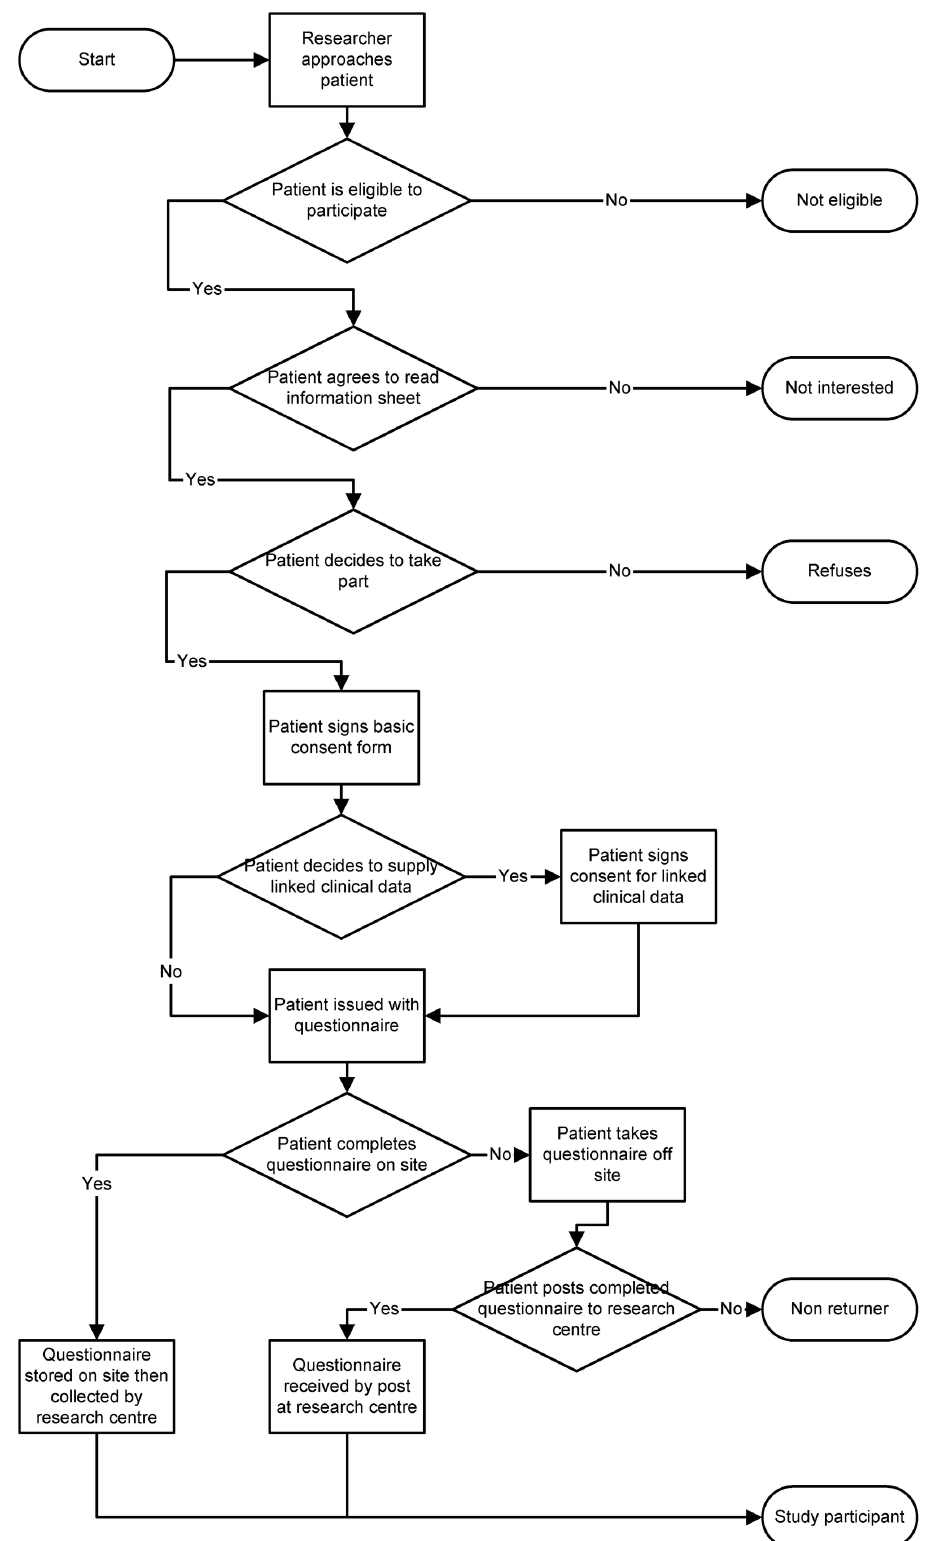
Figure 1. Flowchart of ASTRA clinic recruitment and questionnaire collection procedures.